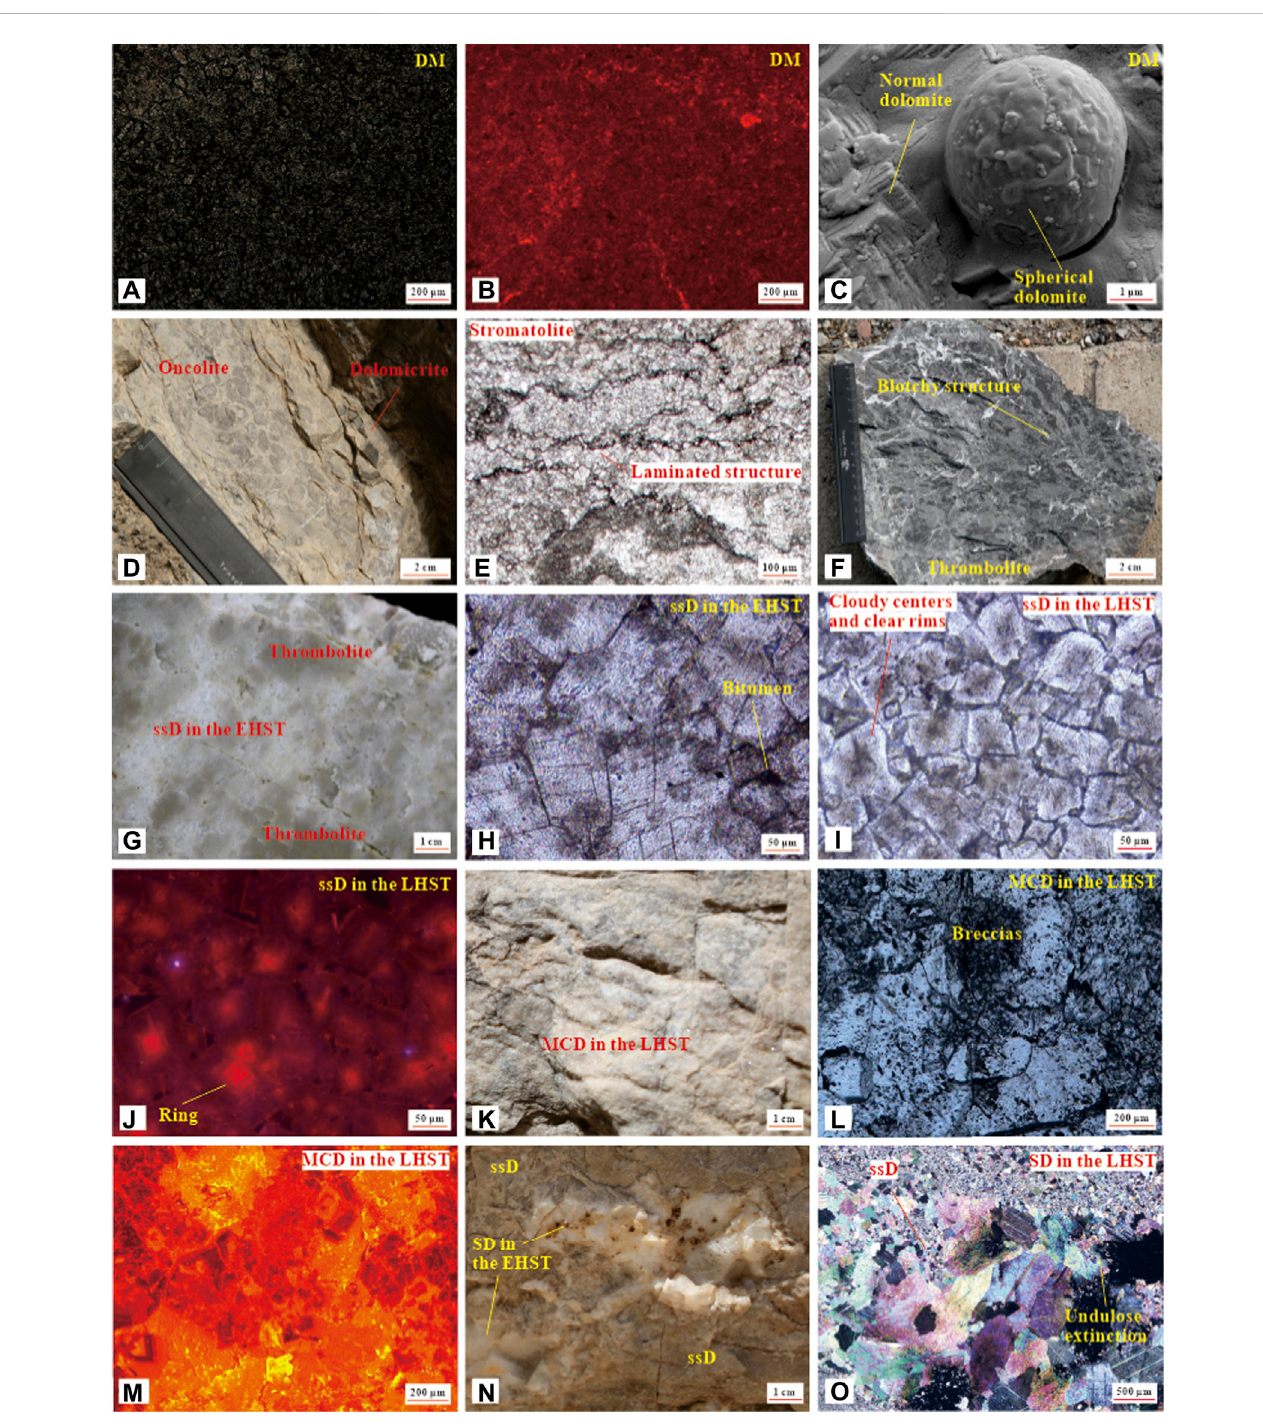
FIGURE 4 Petrological characteristics of the upper changping formation. (A – B) Plane-polarized light/CL image, DM, microcrystalline structure, dark red CL. (C) SEMimage,sphericalandnormalrhombicdolomite.Thesamplesshownin (A – C) arefrom1.2 minEHST,XiaweidianSection. (D) Outcropimage,oncolitesof unattached spherical structure associated with DM, 1.5 m in EHST, Dingjiatan Section. (E) Plane-polarized light image, stromatolite of laminated structure, 18.8 m in LHST, MiaofengshanSection. (F) Hand specimenphotograph, thrombolite of blotchy structure, 2.5 min EHST, Dingjiatan Section. (G) Polished hand specimen photograph, ssD of unclear original structure accompanied with thrombolite. (H) Plane-polarized light image, ssD of obliterative texture. Samples shown in panels (I – J) are from 7.0 m in EHST, Miaofengshan Section. (I – J) Plane-polarized light/CL image, ssD, foggy centres and clear rims, or